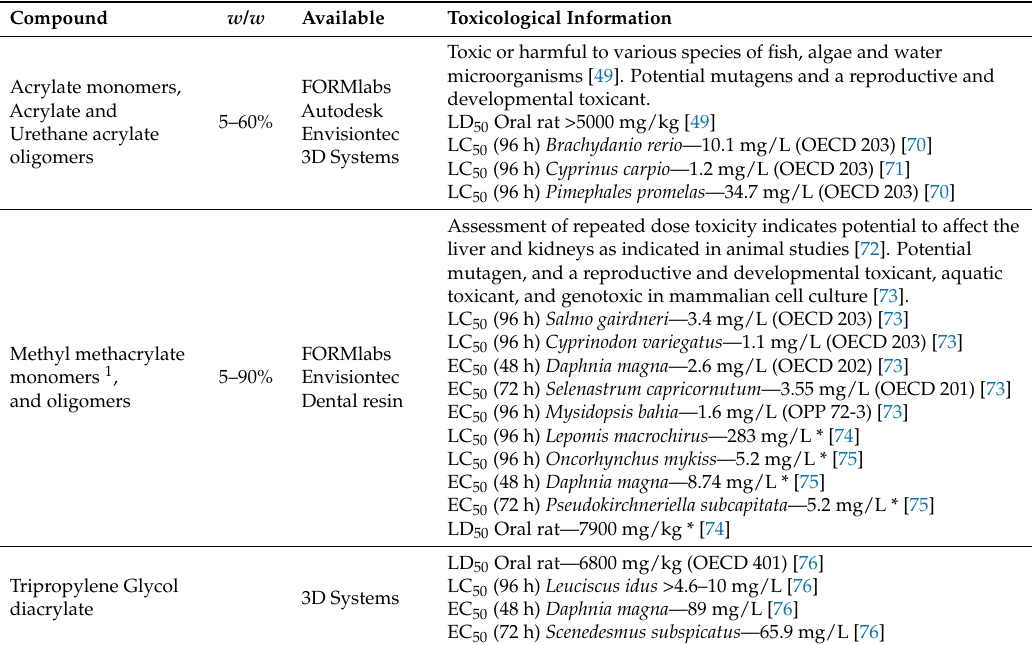
Table 2. Summary of toxicity data available for photopolymers used in stereolithography